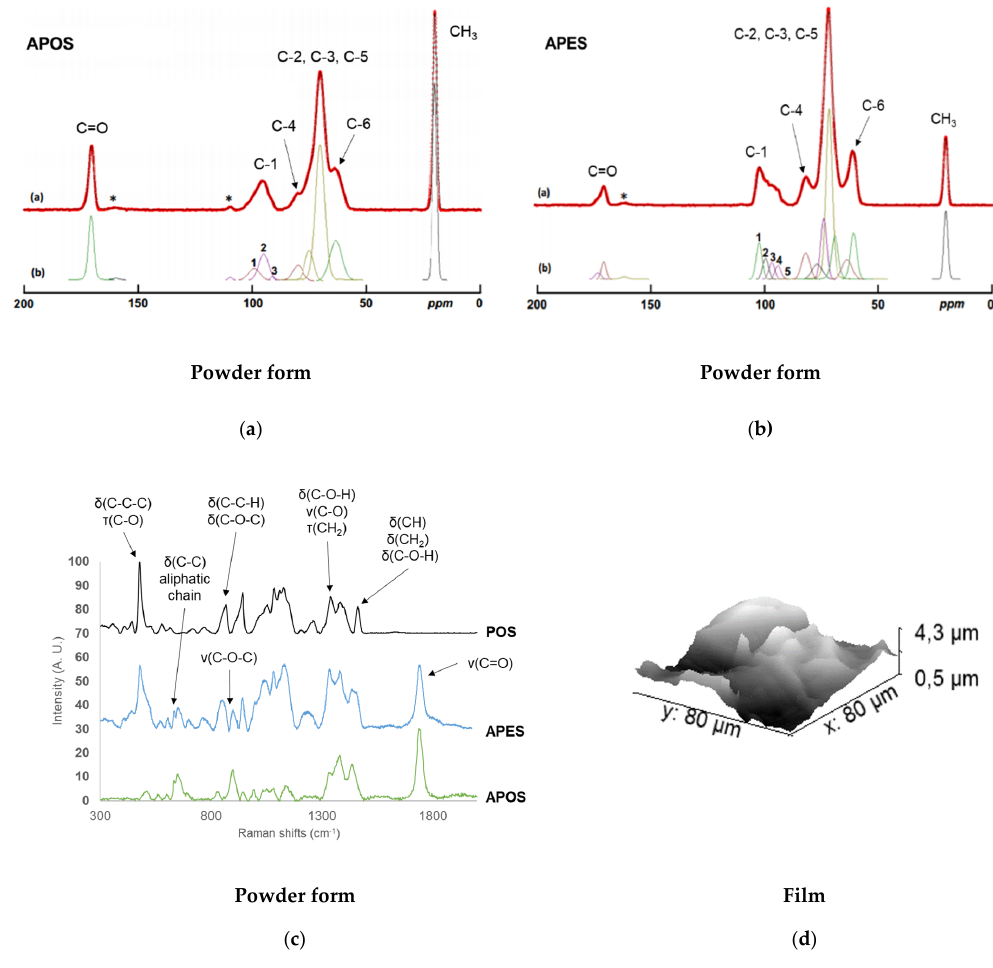
Figure 7. Bulk and surface characterization of APES and APOS Solid-state 13 C-NMR spectra obtained for APOS ( a ) and APES ( b ) and their spectral decomposition, Raman spectra of POS, APOS and APES ( c ), AFM topography image of APES ( d ). The DS of APOS and APES before deacetylation were 2.4 and 0.7, respectively. *Spinning side band.